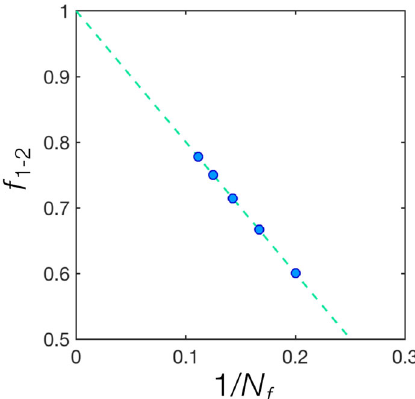
Fig. 7 Size scaling of the activated transfer edges in the highest-power machines. The fraction f 1 − 2 of the activated transfer edges between single- hole states and double-hole states is plotted against the inverse of system size 1/ N f . Blue dots correspond to numerical values of f 1 − 2 extracted from the state-transfer network shown in Fig. 4a – d. Green dashed line indicates the analytical scaling f 1 − 2 = 1 − N f